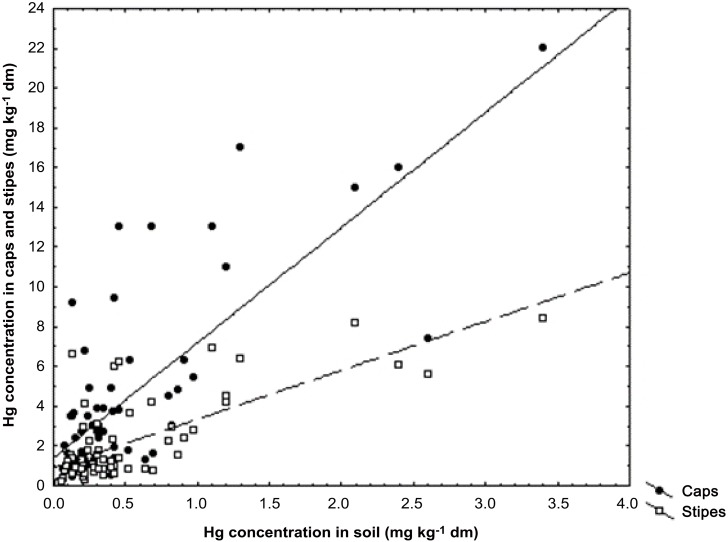
Relationships between Hg concentration in the caps (y = 1.4106 + 5.7865 * x; r = 0.7769 p < 0.0001; r2 = 0.6036) and stipes (y = 0.8913 + 2.4557 * x; r = 0.7312; p > 0.0001; r2 = 0.5346) of the fruiting bodies of Boletus spp. from the Yunnan and Sichuan Provinces and soil beneath the fruiting bodies.